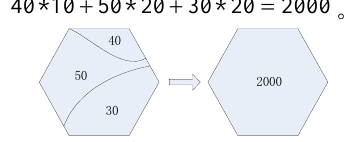
Figure 6. The total information mapping diagram